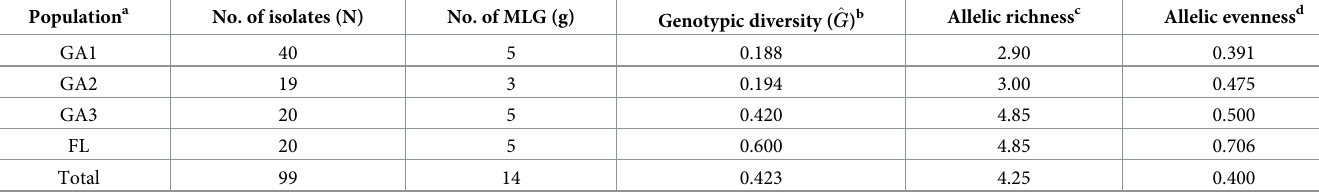
Table 3. Estimates of genetic diversity for Fusarium oxysporum f. sp. niveum population from the southeastern United States. Population a No. of isolates (N)